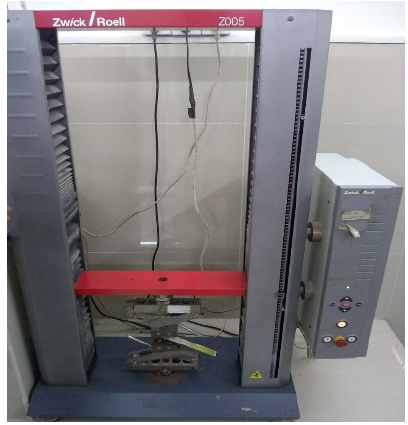
Figure 2. A 5 kN universal tensile testing machine .